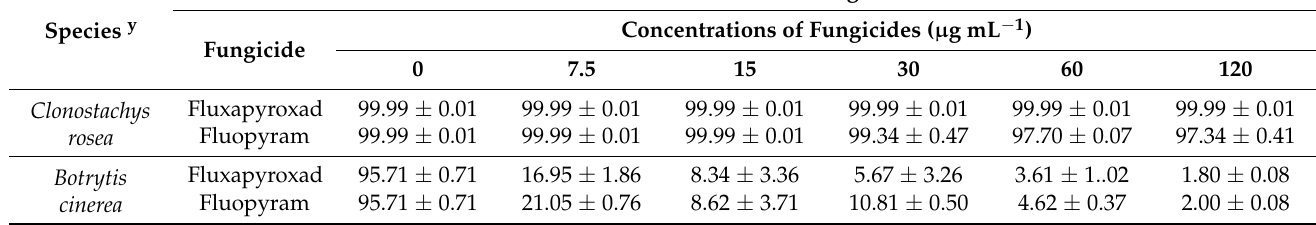
Table 2. In vitro germination rate of conidia of Clonostachys rosea and Botrytis cinerea under different fungicide